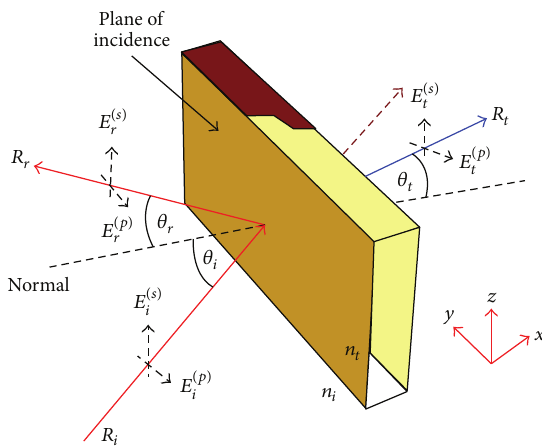
Figure 7: Reflection and transmission from a single